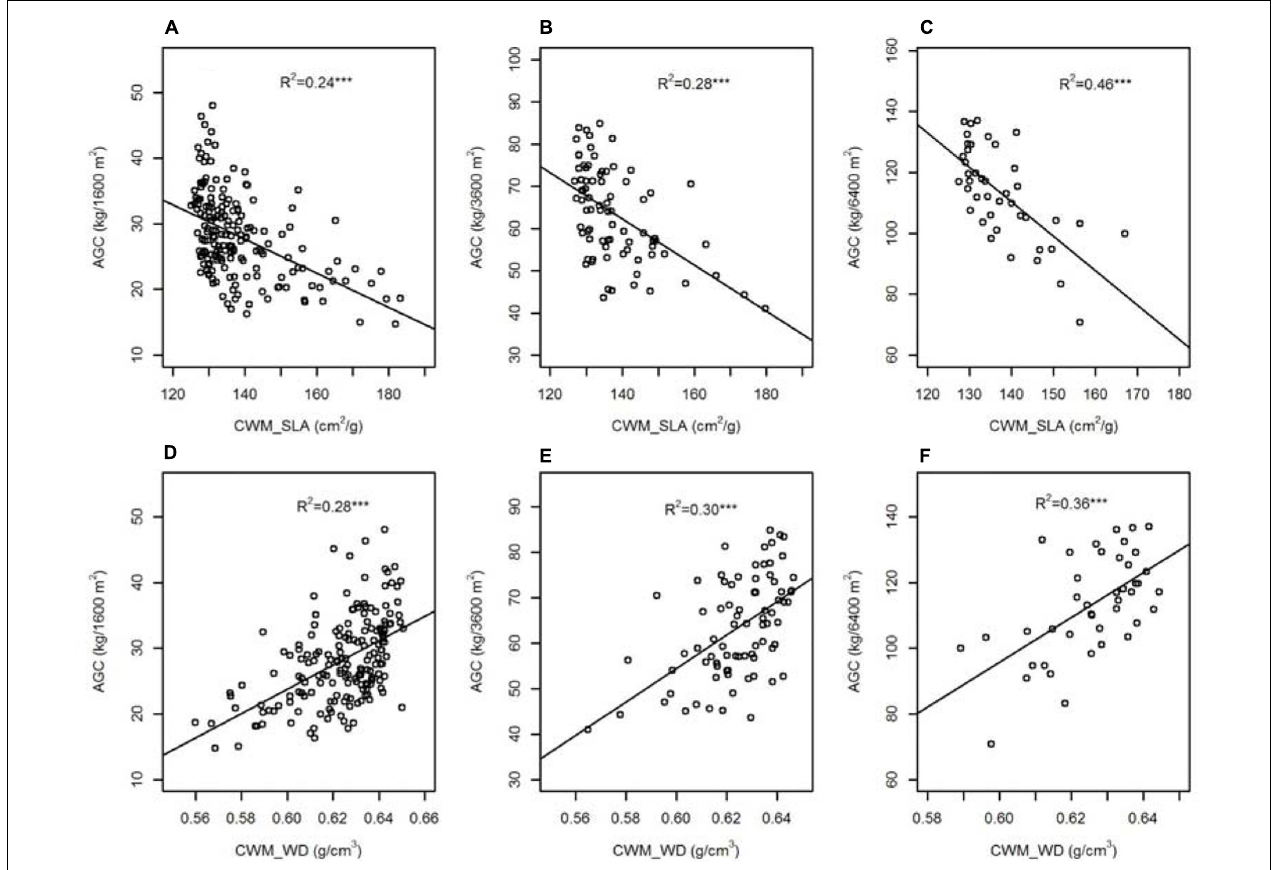
FIGURE 2 | The relationships between specific leaf area/wood density at community level (CWM_SLA/CWM_WD) and aboveground carbon stock (AGC) across nested spatial scale [ (A,D) 40 m × 40 m, (B,E) 60 m × 60 m, (C,F) 80 m × 80 m]. ∗∗∗ P <